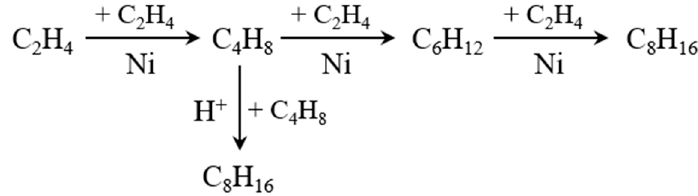
Figure 5. Reaction pathway of C 8 H 16 formation in the oligomerization of ethylene on Ni/Al-HMS.